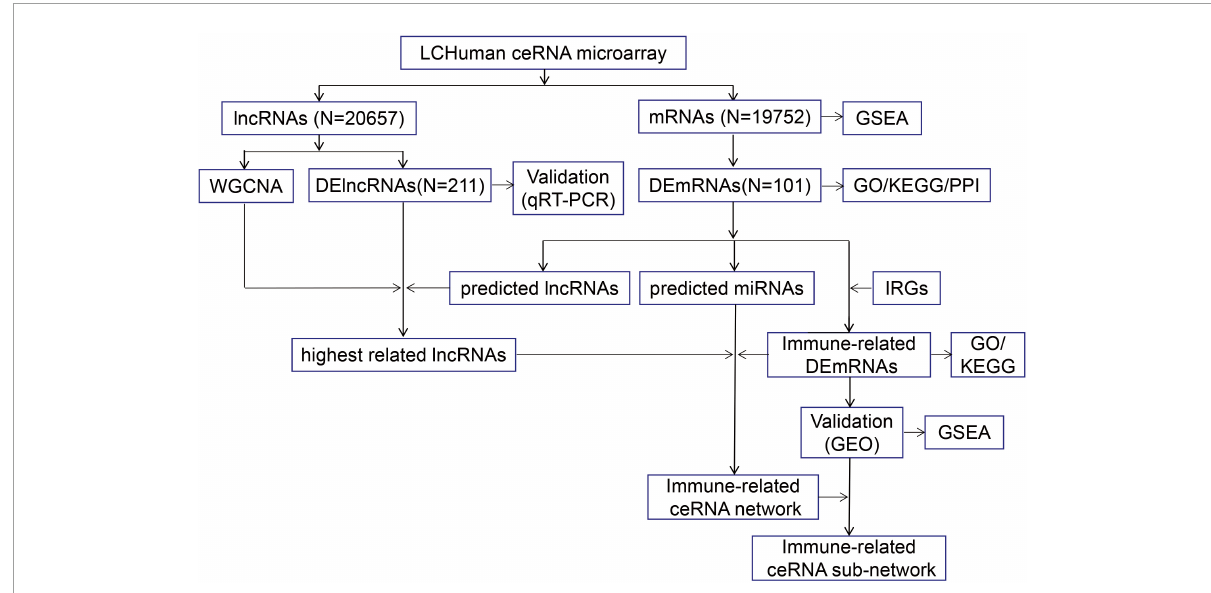
FIGURE1 The flow chart of this study. The peripheral blood from ICH patients and control subjects were collected for LCHuman ceRNA microarray and verification using qRT-PCR. The DElncRNAs and DEmRNAs were identified and GO, KEGG, PPI, and GSEA were performed. Then, we got the highest related lncRNAs to ICH by taking the intersection of strongest correlated lncRNAs module by WGCNA, DElncRNAs from our ceRNA microarray, and predicted lncRNAs. We took the intersection of DEmRNAs and IRGs to obtain immune-related DEmRNAs. TargetScan and miRanda were used to predict the interactions between three types of RNAs, and the immune-related ceRNA network was constructed. In addition, we performed GO and KEGG on the immune-related DEmRNAs, verified their expression by the GSE24265 and the GSE125512 from GEO datasets, and conducted GSEA to identify potential pathways of the immune-related DEmRNAs. Finally, we constructed the immune-related ceRNA